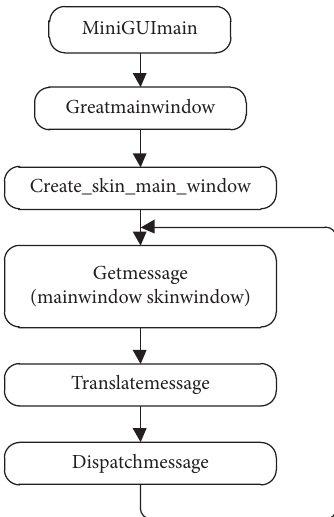
Figure 2: The main loop of the interface control